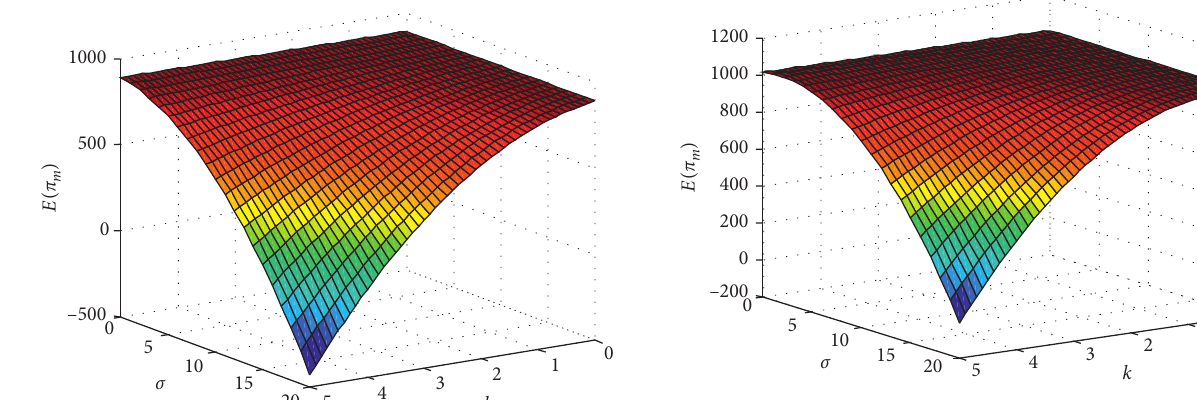
Figure 7: The trend of the manufacturer’ profits under Nash